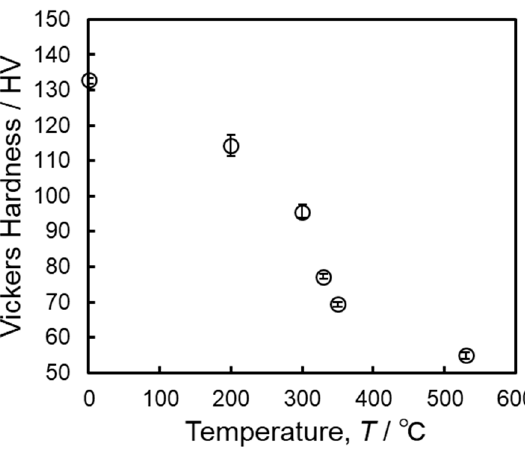
Figure 8. Change in Vickers hardness measured in the sections parallel to the building direction ( z axis) of the LPBF-fabricated Al–12%Si alloy samples as a function of annealing temperature.